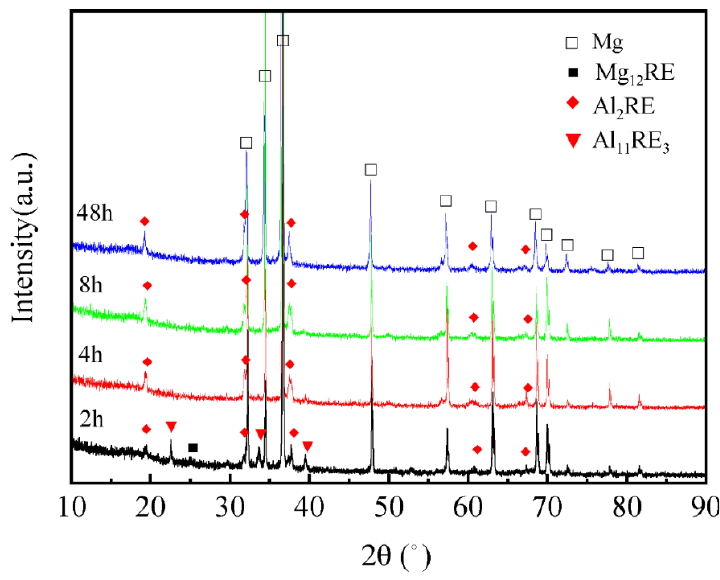
Figure 3. XRD patterns of the Mg-3Y-4Nd-2Al alloy after solution treatment at 545 °C for different time periods.